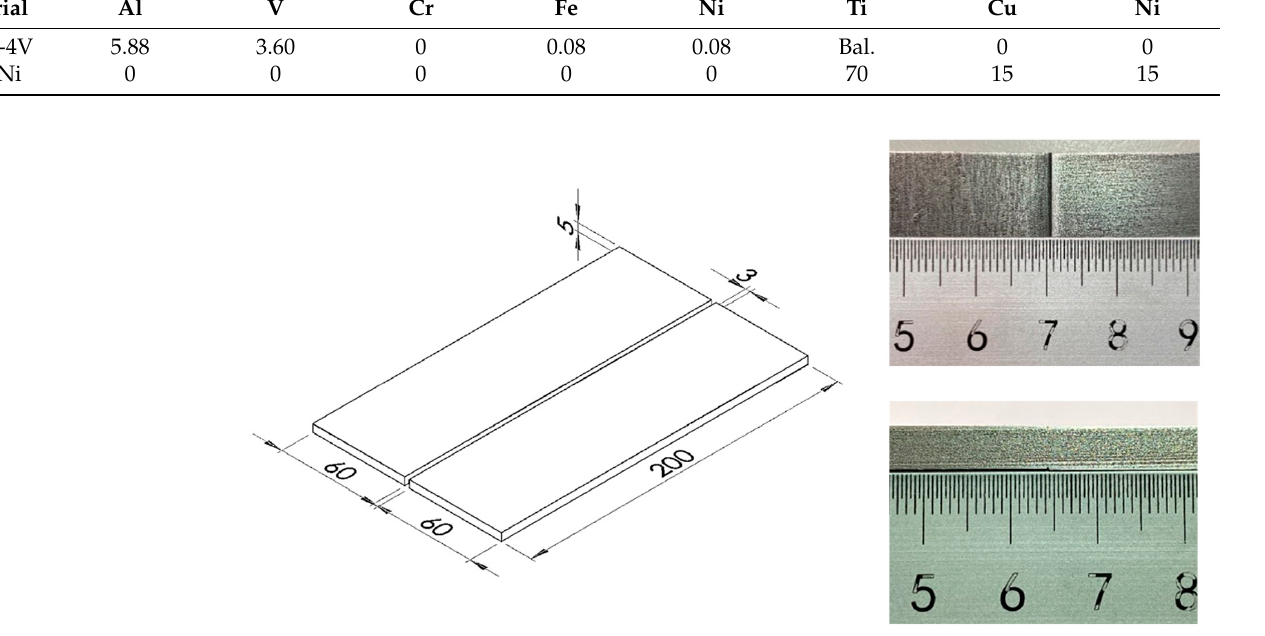
Table 1. The constituent elements of the base and filler metals (wt.%). Material